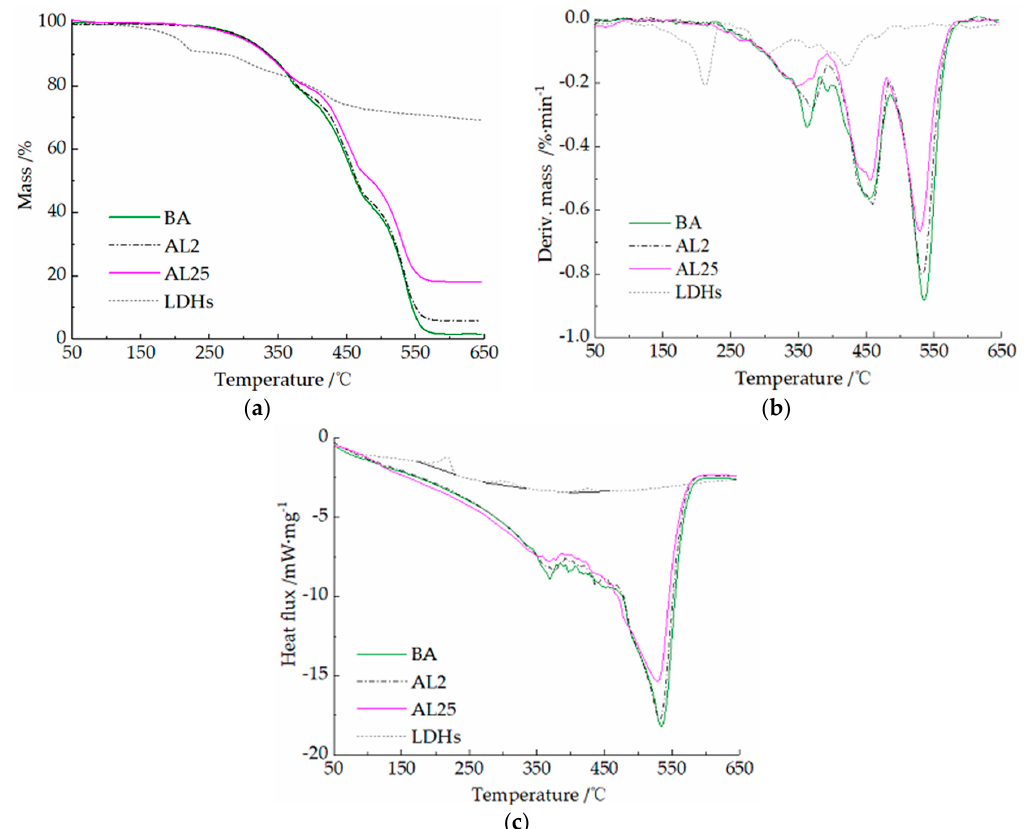
Figure 8. Thermogravimetry–differential scanning calorimetry (TG–DSC) curves of LDHs and asphalt binders: ( a ) TG, ( b ) derivative mass loss (DTG), and ( c ) DSC.